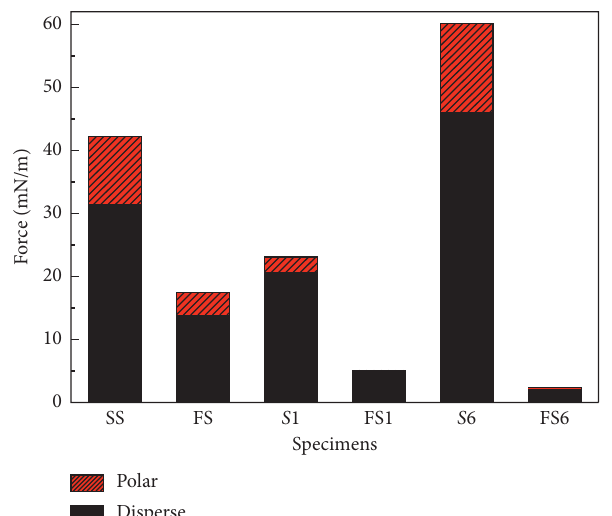
Figure 4: Disperse and polar components of surface free energy on specimens, showing both fluorination and micro/nanostructure are important for reducing surface free energy.